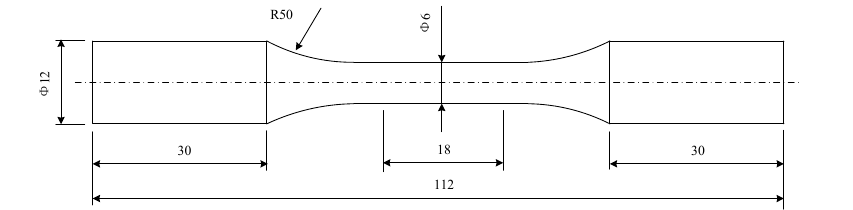
Figure 4. The geometry of fatigue test specimen (unit: mm).